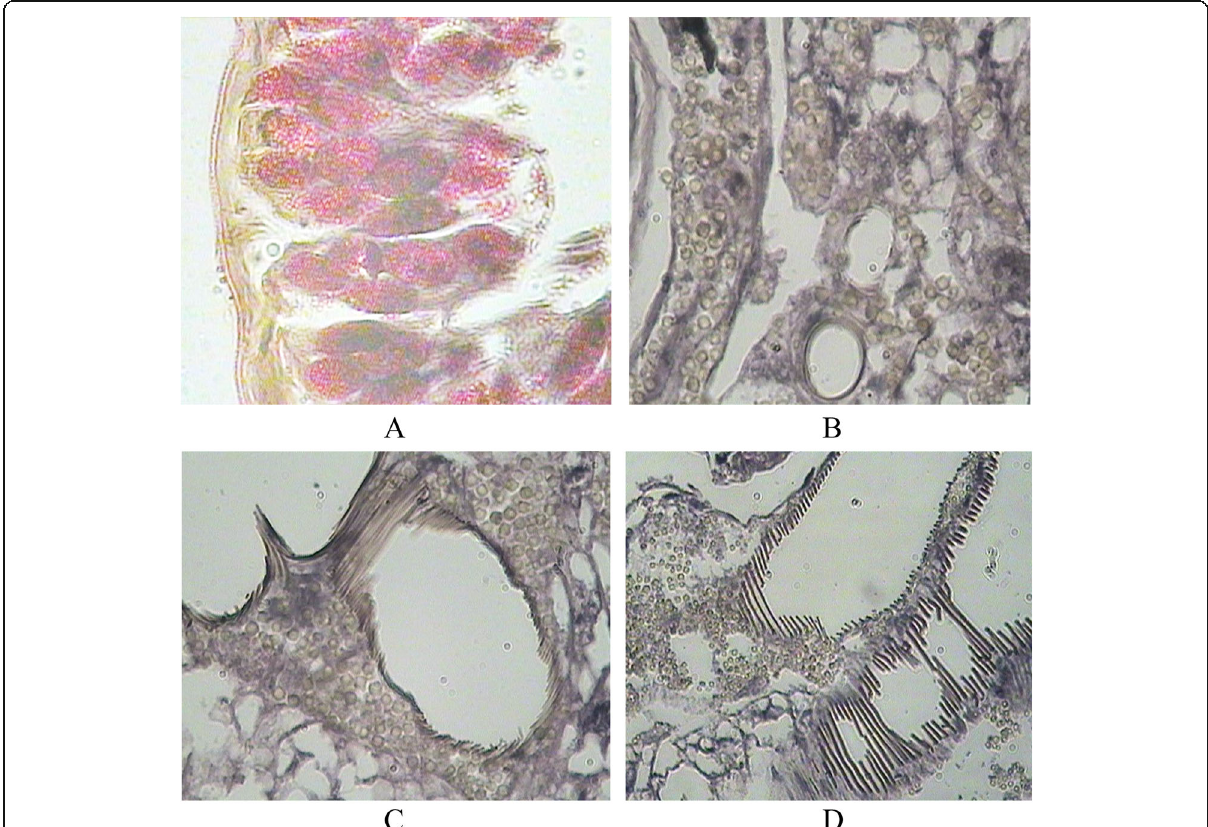
Fig. 1 Cross sections in Galleria mellonella larvae 6 days post-infection with Gm MNPV. a PIBs filling the nuclei of hypodermal cells under the body cuticle. b PIBs in nuclei of fat body cells. c and d PIBs in epithelial cells of the